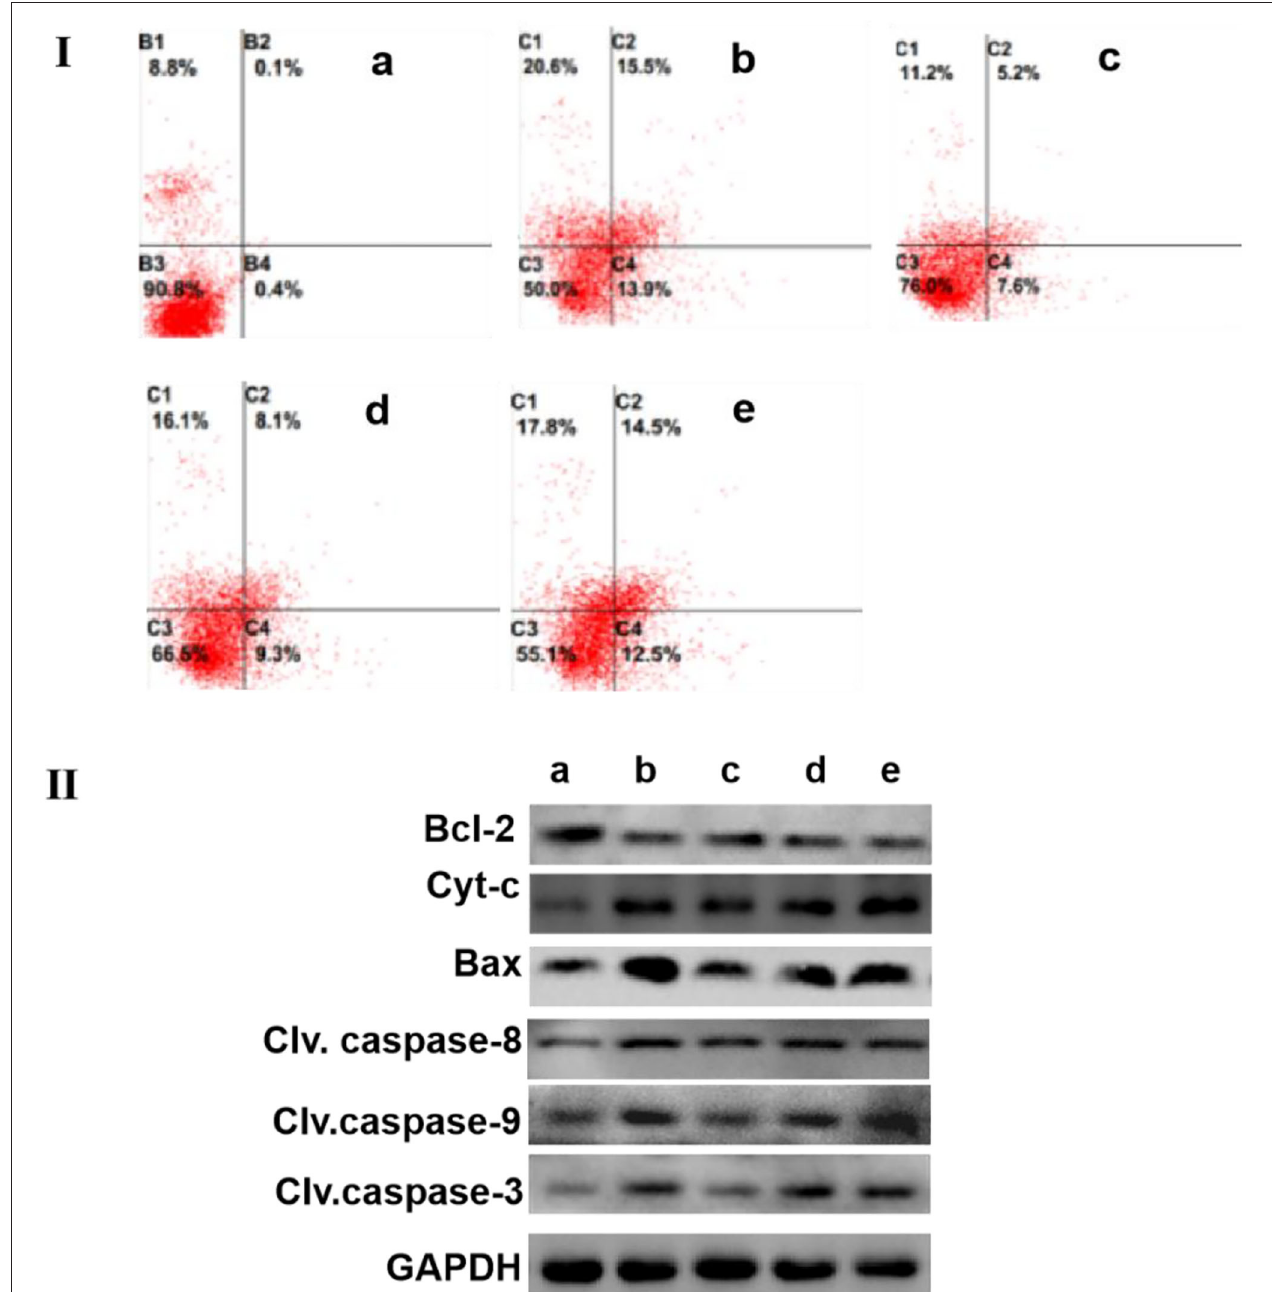
FIGURE 4 | SCIP improves the apoptosis of MCF-7. (I) The apoptosis level of MCF-7 cells was determined by flow cytometry analysis. MCF-7 Cells were cultured and incubated with 20 µ g/ml of capecitabine and various concentrations of SCIP (27.8, 83.3, and 250 µ g/ml) for 12h, then, MCF-7 cells were stained with annexin V and PI, and flow cytometry was carried out to detect its apoptosis rate. (II) The expression of apoptosis-related proteins was investigated by western blots. MCF-7 cells were cultured and incubated with 20 µ g/ml of capecitabine and various concentrations of SCIP (27.8, 83.3, and 250 µ g/ml) for 12h; After the treatment, the cells were collected to extract the total proteins and performed the western blot analysis to measure the expression of apoptosis proteins. a: Control group, MCF-7 cells were stimulated by PBS; b: Capecitabine group, MCF-7 cells were incubated by 20 µ g/ml of capecitabine for 12h; c: Low dose SCIP group, MCF-7 cells were incubated by 27.8 µ g/ml of SCIP for 12h; d: Moderate dose SCIP group, MCF-7 cells were incubated by 83.3 µ g/ml of SCIP for 12h; f: High dose SCIP group, MCF-7 cells were incubated by 250 µ g/ml of SCIP for 12h.